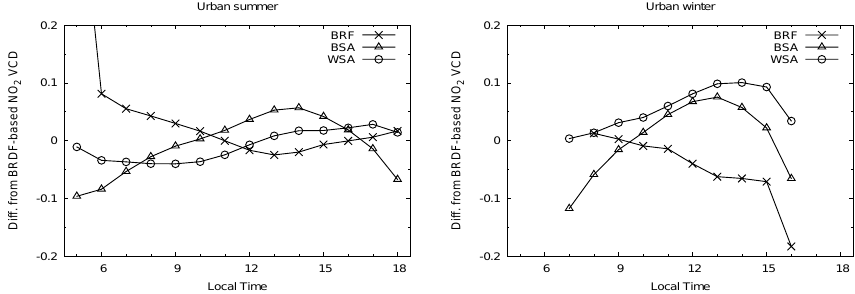
Figure 13. Relative difference of the tropospheric NO 2 VCDs from the value obtained with full BRDF treatment when implementing the values of BRF, BSA, and WSA surface as LER in the RTM in summer (left) and winter (right). The results for the urban surface type are shown. The VCD for BRDF is assumed to be a true value.